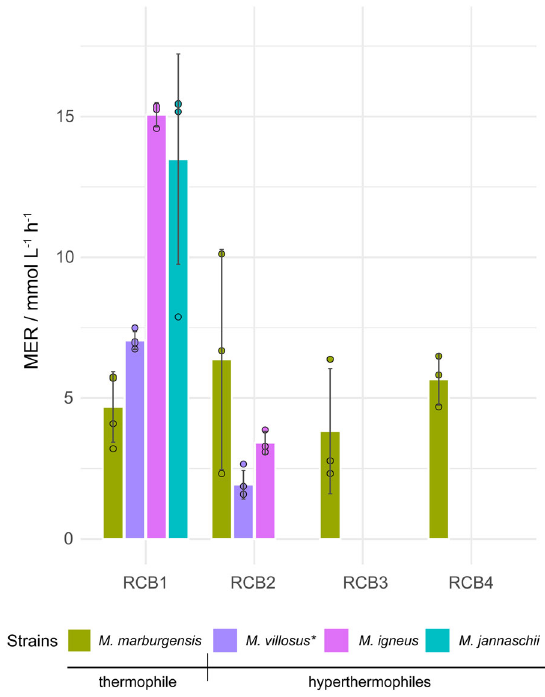
Fig. 4 Results of RCB cultivations of thermophilic and hyperthermophilic methanogens in the SBRS at 50bar. The RCB cultivations were performed in quadruplicates with four runs RCB1, RCB2, RCB3, and RCB4. Mean and standard deviation of MER / mmolL − 1 h − 1 is shown. Thermophile: Methanothermobacter marburgensis Marburg (65°C, MM